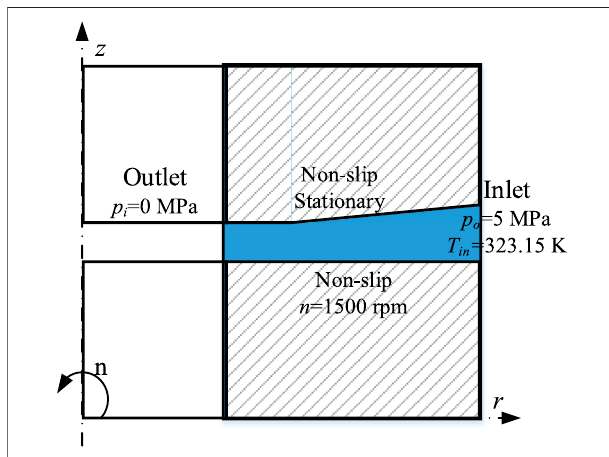
FIGURE 3 | Schematic of the boundary